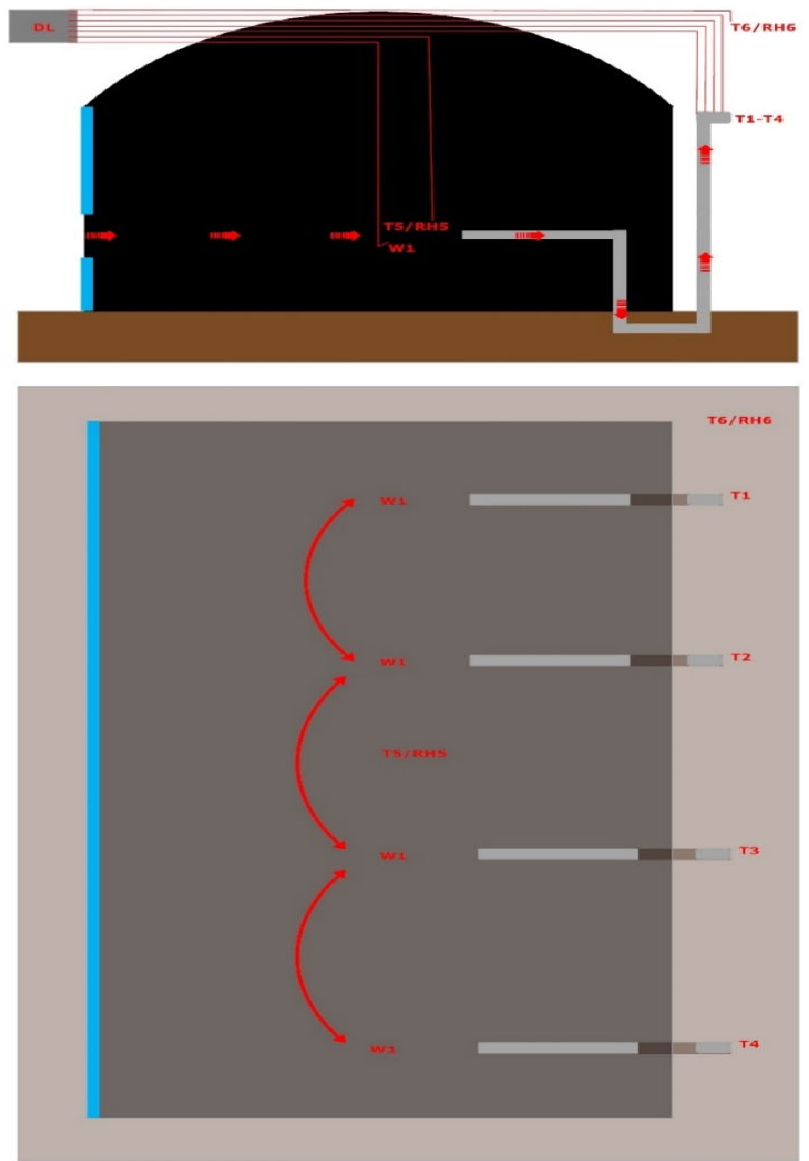
Figure 5. Sensors’ overview and positions.